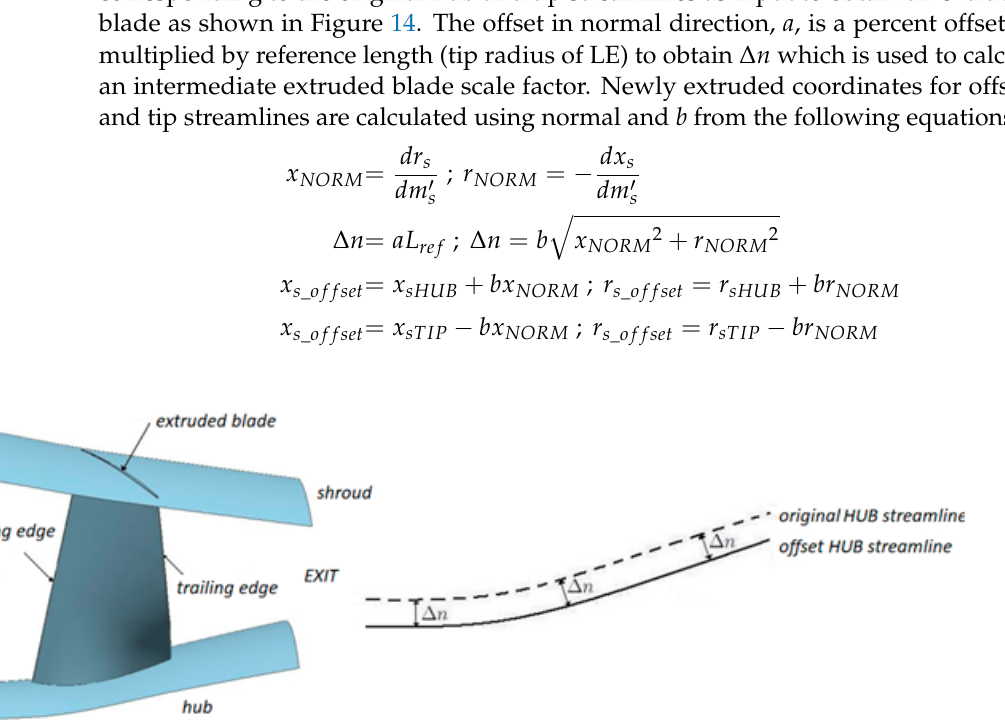
Figure 14. Normal offset of hub streamline and extruded blade at the tip.